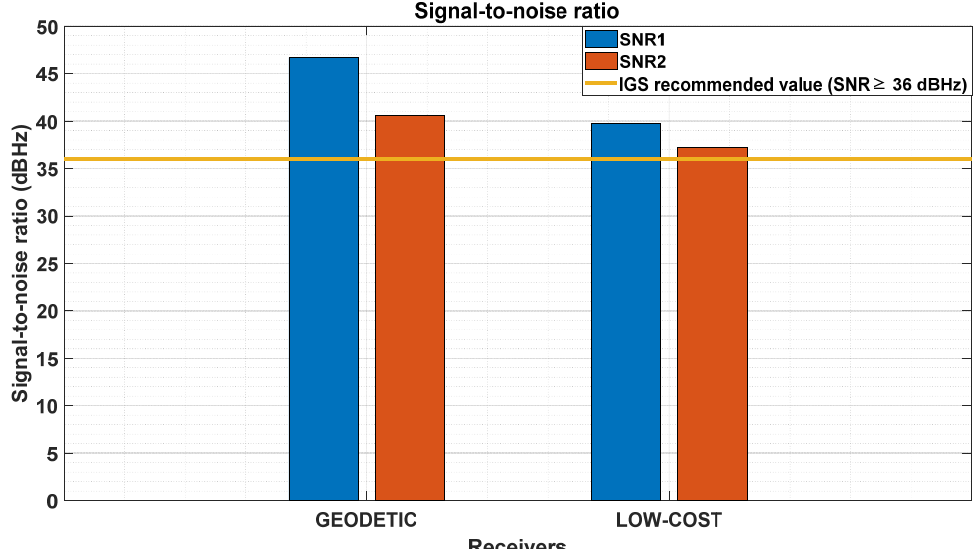
Figure 5. Signal-to-Noise ratio for the low-cost and geodetic GNSS receivers. Yellow line: IGS recommended value (SNR ≥ 36 dBHz).